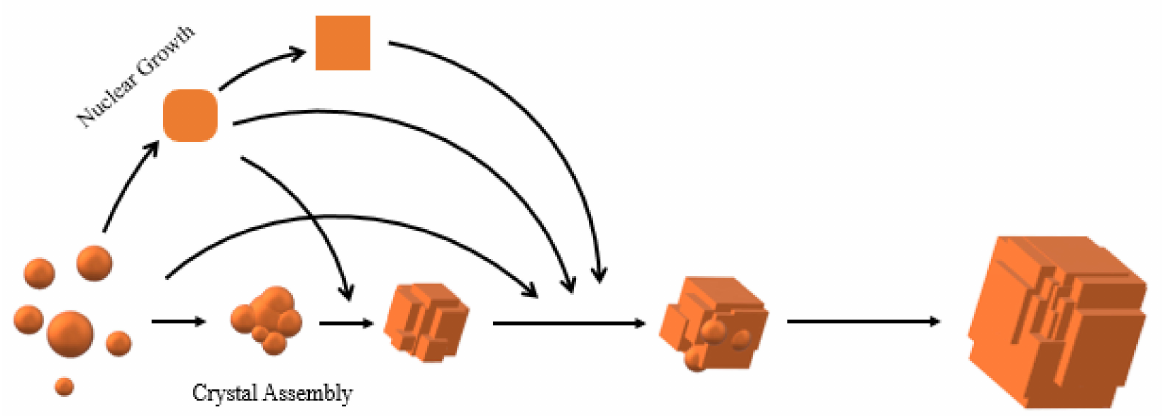
Figure 5. Growth process of SSZ-13 crystal with the unconventional process.